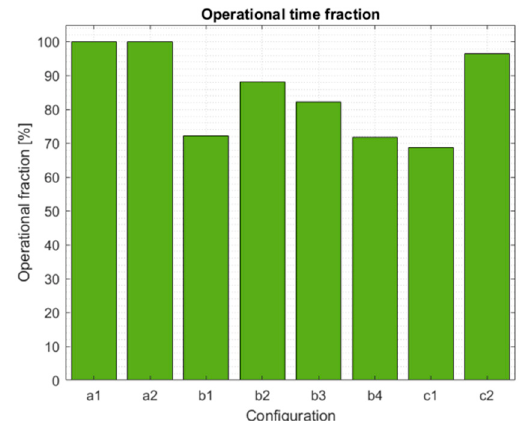
Figure 6. Operation time fraction and its reduction due to PEC(-PV) device tilt constraints (Figure 1c) for geometrical configurations listed in Table 5. A ratio of 100% corresponds to a configuration operational from sunrise to sunset. Location: Seville, Spain. Table 7. Geographical coordinates and reference DNI of selected site locations.